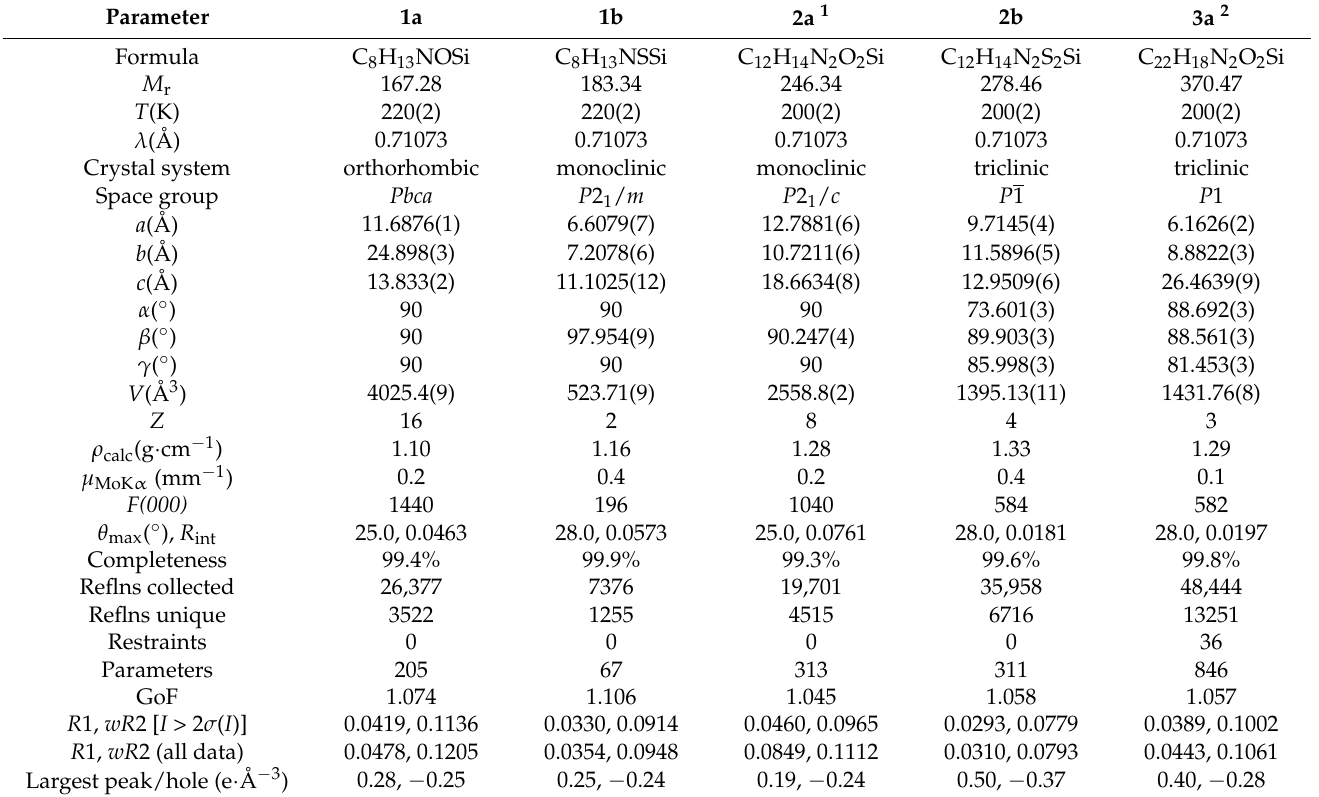
Table A1. Crystallographic data from data collection and refinement for 1a , 1b , 2a , 2b and 3a .